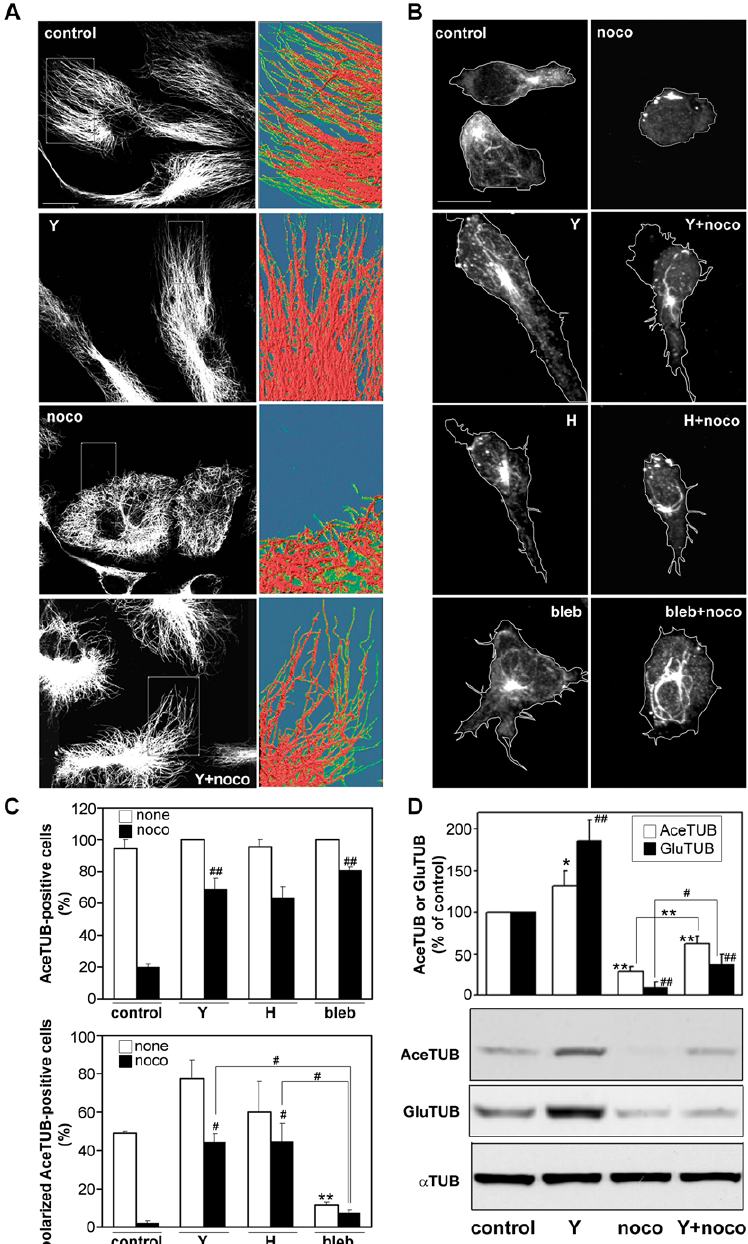
Figure 9. ROCK inhibitors increase microtubule stability. (A) HUVECs were left untreated (control) or were incubated with 0.1 m M nocodazole for 60 min (noco) and/or 5 m M Y-27632 (Y) for 15 min then 0.1 m M nocodazole for 60 min (Y + noco). To visualize MT distribution, cells were extracted with 0.05% Triton X-100 to remove monomeric tubulin, then stained with anti- a -tubulin antibodies. The areas marked with a white rectangle have been enlarged and pseudocoloured using the image analysis program LaserPix to help visualise MT morphology in untreated and treated cells. (B, C) CCRF-CEM cells were treated with or without 10 m M Y-27632 (Y), 0.4 m M H-1152 (H) or 50 m M blebbistatin (bleb) for 30 min, then with or without 20 m M nocodazole (noco) for 10 min, then plated on ICAM-1 and stimulated with 20 nM CXCL12 for 5 min. Localization of acetylated tubulin (Ace- TUB) was examined by staining with anti-Ace-TUB antibody. (B) Representative confocal images; the outline of cells is indicated by white lines; (C) percentage of filamentous Ace-TUB positive cells (top), and % of morphologically polarized cells (with uropod and a leading edge) containing filamentous Ace-TUB (bottom). Data represent mean 6 SEM from 3 independent experiments, n=150 to 250 cells in each condition, ## p , 0.01 for % of Ace-TUB positive cells compared to nocodazole-treated cells in the top panel, **p , 0.01 for % of morphologically polarized cells compared to untreated control, or # p , 0.05 compared to nocodazole-treated cells, to Y-27632 + nocodazole-treated cells or to H-1152 + nocodazole-treated cells (indicated with bridge), Student’s t-test. (D) Western blot analysis of Ace-TUB and Glu-TUB levels in CCRF-CEM T cell lysates treated with or without 10 m M Y-27632 (Y) for 30 min and subsequently with or without 20 m M nocodazole (noco) for 10 min. Data represent quantification of densitometry results (Mean 6 SD) of three independent experiments, normalised to the total a -TUB level and indicated as fold increase in Ace-TUB or Glu-TUB over the level in control cells; *p , 0.05, **p , 0.01 for Ace-TUB, or # p , 0.05, # p , 0.01 for Glu-TUB compared to control (without bridge), or to nocodazole- treated cells (indicated with bridge); Student’s t-test.